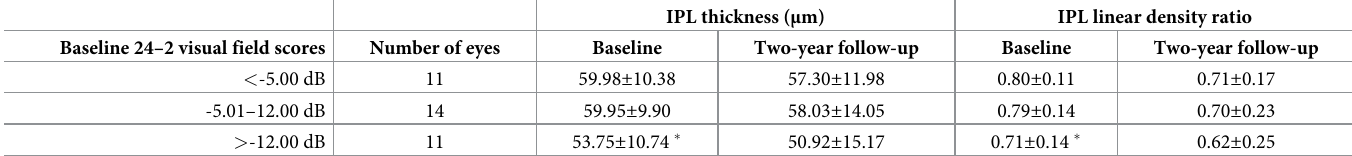
Table 3. IPL alterations in glaucoma subgroups with different stages.